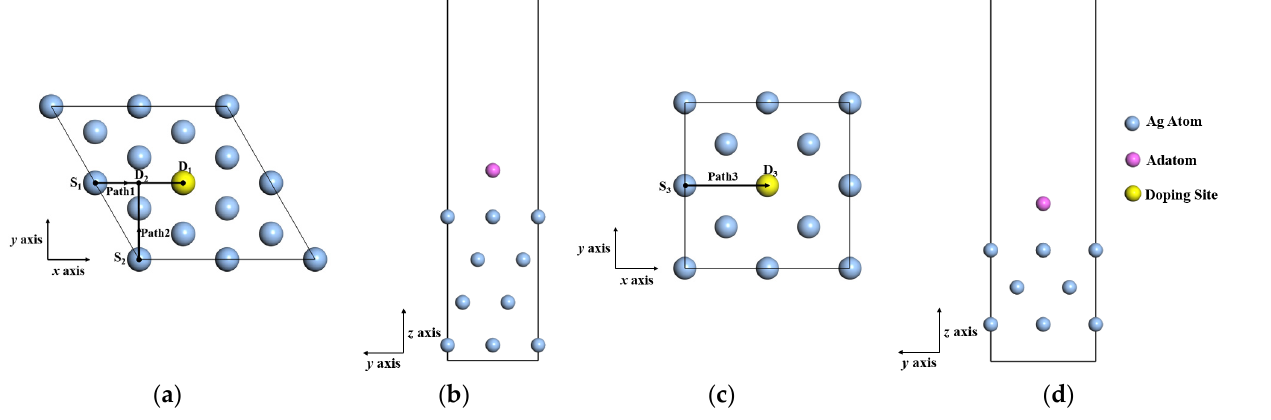
Figure 1. Schematic illustration of adatom migration on silver surface. ( a ) Top view of migration paths on Ag (111) surface, and D 1 denotes the doping site; ( b ) side view of adsorption distance between adatom and Ag (111) substrate; ( c ) top view of migration paths on Ag (100) surface, and D 3 denotes the doping site; ( d ) side view of adsorption distance between adatom and Ag (100) substrate. The adsorption energy E ad of an adsorbed atom on silver surface is defined as fol-